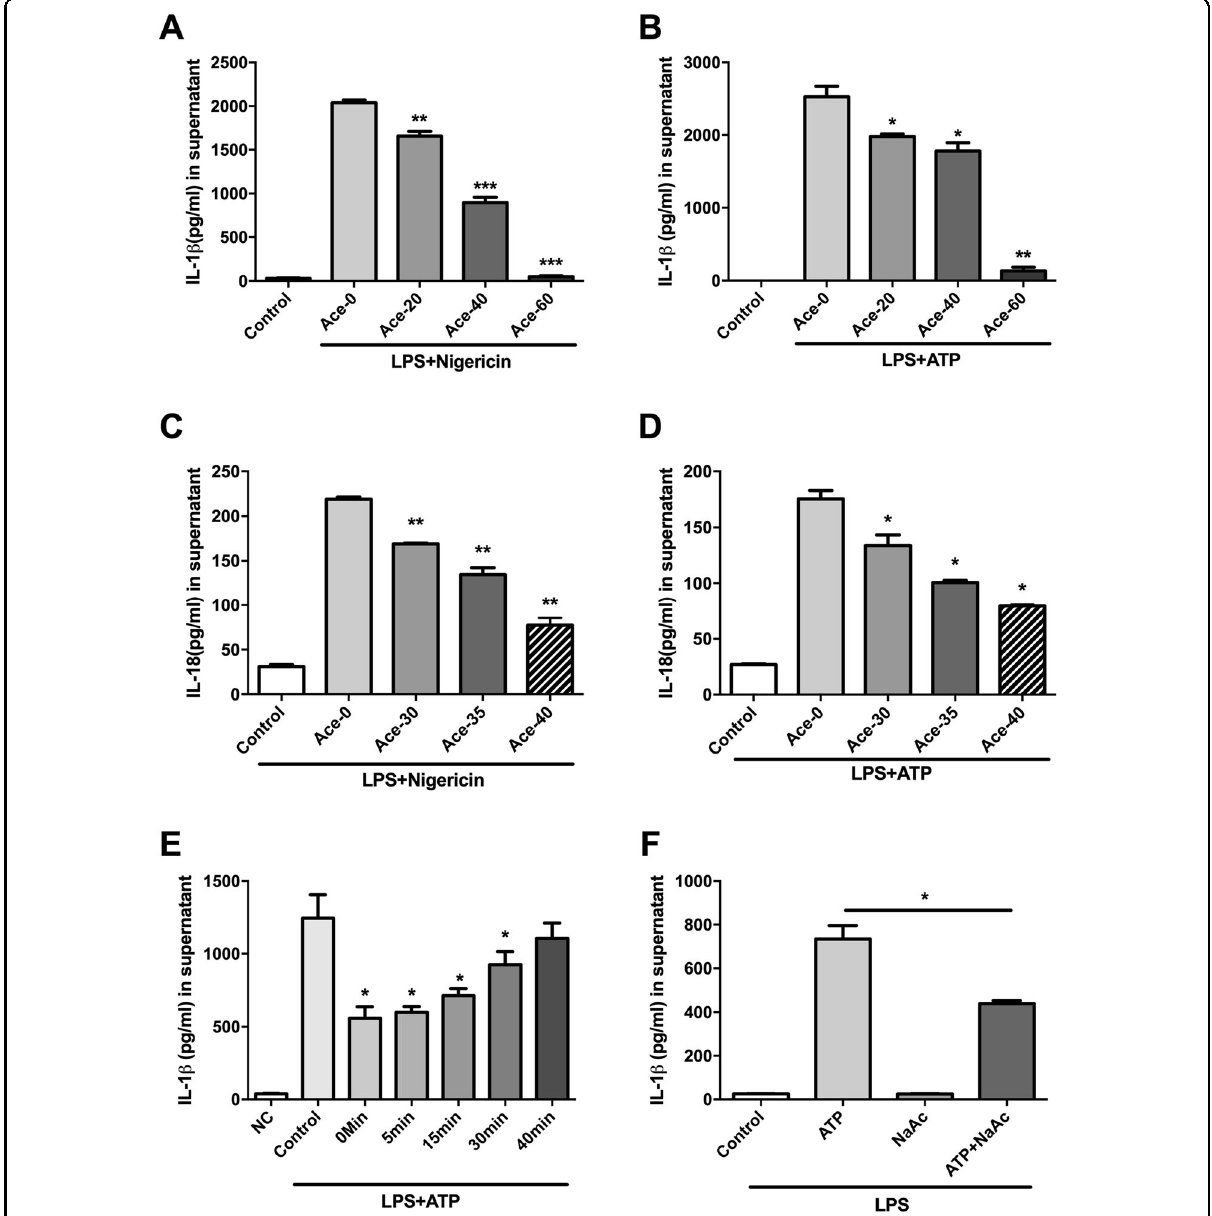
Fig. 1 Acetate attenuates in fl ammasome activation in vitro. a – d ELISA of IL-1 β ( a , b ) and IL-18 ( c , d ) in BMDMs treated with LPS + nigericin or LPS + ATP at different doses (20, 30, 35, 40, and 60 mM) ( n = 3); e ELISA of IL-1 β after sodium acetate treatment ( n = 3); f ELISA of IL-1 β at different time points after acetate treatment in LPS-primed ATP-treated BMDMs ( n = 3); n = biological replicates; Data are presented as the mean ± SEM. * P < 0.05, ** P < 0.01, and *** P < 0.001, Student ’ s t- test compared with the control